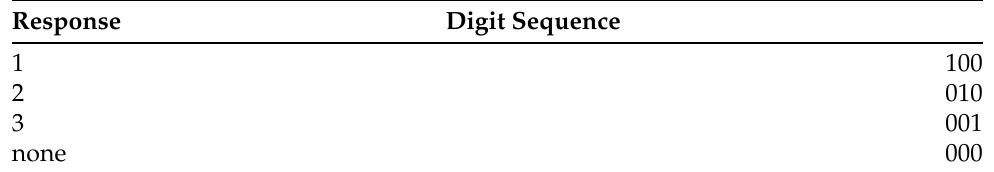
Table 2. Encoding of the response for output values.